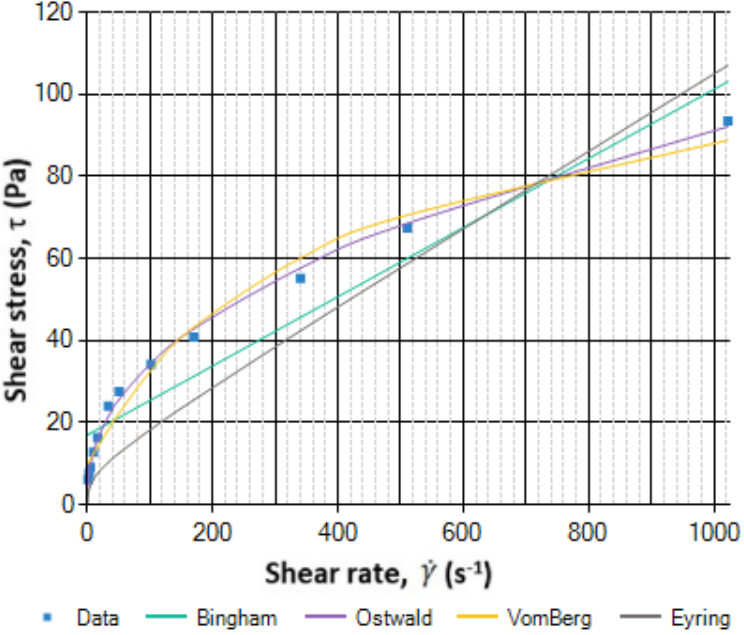
Figure 8. Comparison of the selected rheological models, cement w/c 0.5 with an addition of PSP 042.